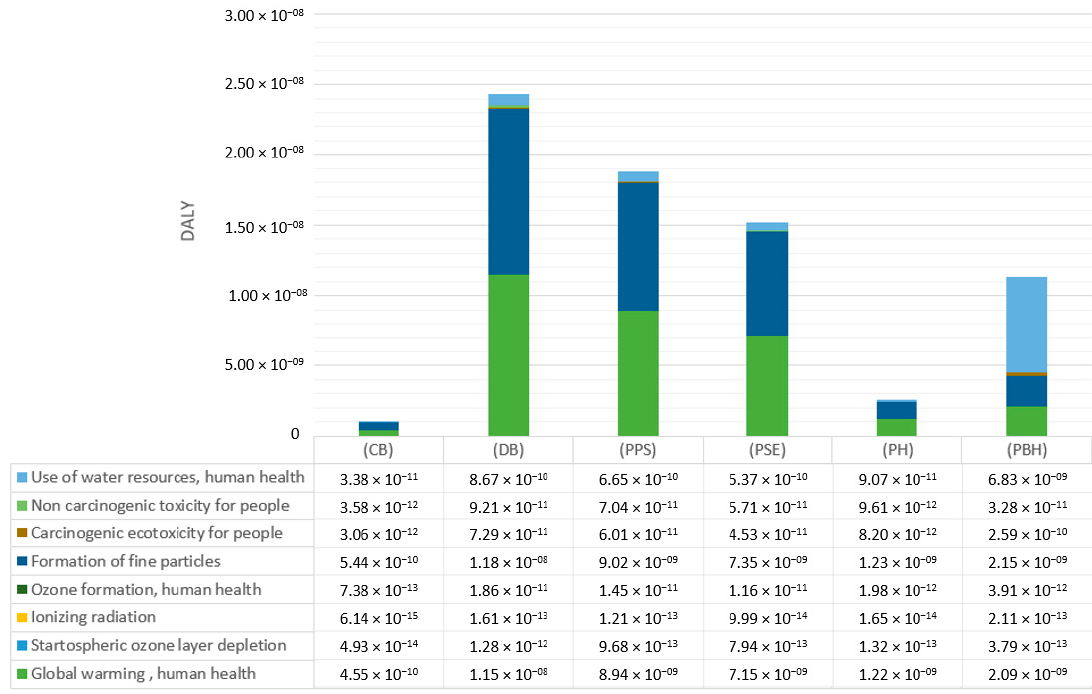
Figure 6. Results of characterization of environmental impacts for 8 impact categories in terms of human health.